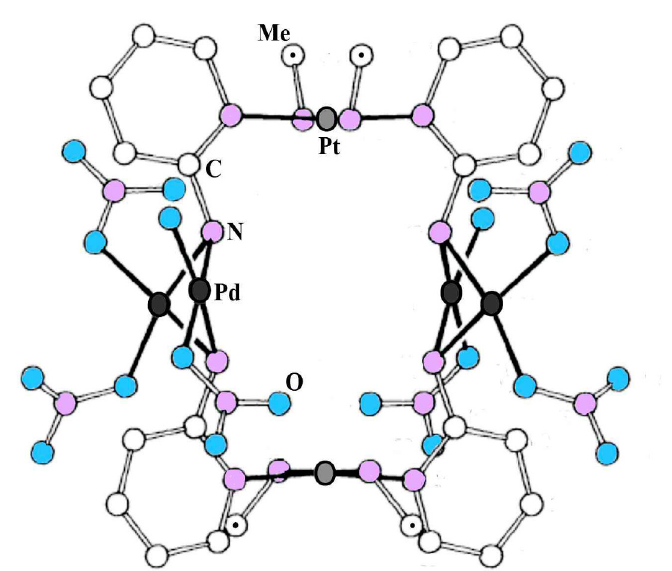
Figure 7. Structure of [{(MeNH